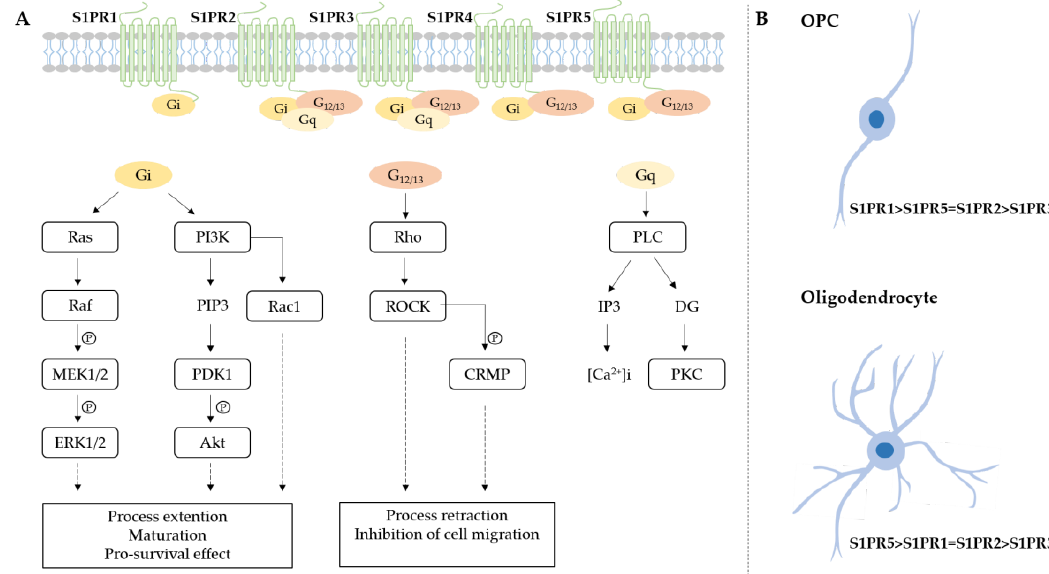
Figure 1. Sphingosine-1-phosphate receptors (S1PRs) expression and main transduction pathways activated in oligodendrocytes progenitor cells (OPCs) and oligodendrocytes. ( A ) Schematic representation of G-protein coupled receptors and main pathways involved after receptor activation. Sphingosine-1-phosphate receptor 1,2,3,5 (S1PR1,2,3,5); mitogen-activated protein kinase (MEK); extracellular signal-regulated kinases (ERK); phosphatidylinositol 3-kinase (PI3K); phosphatidylinositol (3,4,5)-trisphosphate (PIP3); 3-phosphoinositide dependent protein kinase-1 (PDK1); protein kinase B (Akt); phospholipase C (PLC); protein kinase C (PKC); Rho-associated protein kinase 1 (ROCK); collapsin response mediator protein (CRMP). ( B ) S1PRs expression levels in human OPCs and oligodendrocytes [71–75].